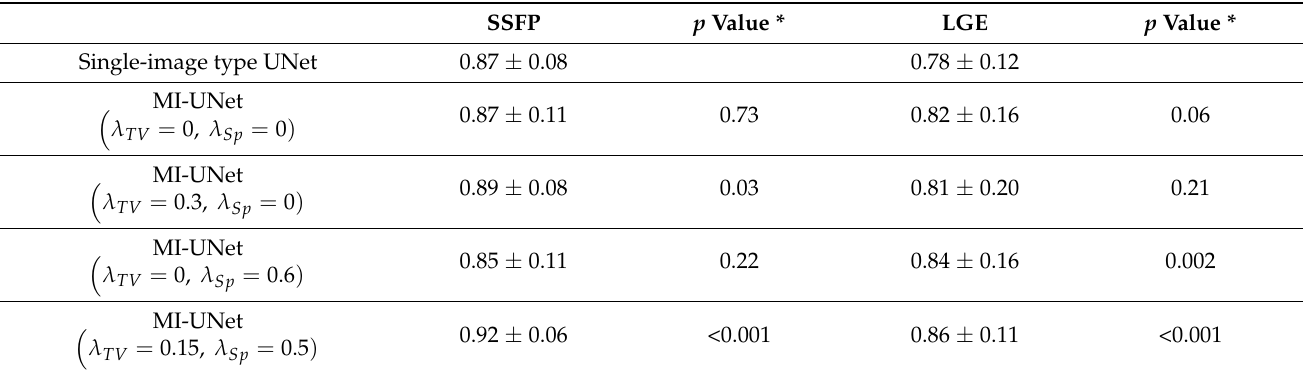
Table 2. Dice Similarity Coefficients of the MI-UNet with Different Constraints.